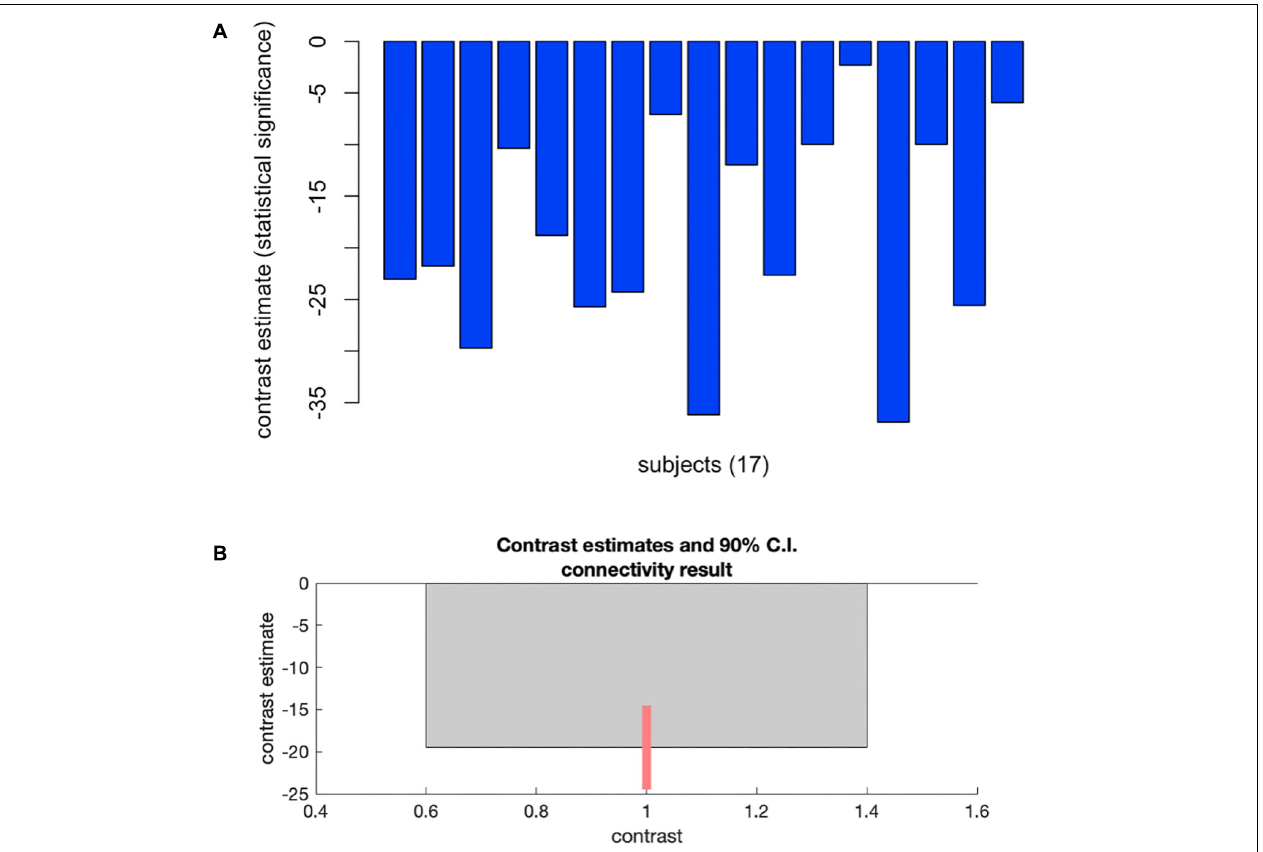
FIGURE 2 | Plots showing changes in whole-brain functional connectivity after a minimum of 60 days of estradiol therapy using multivoxel pattern analysis. (A) Plots individual changes in FC between the cluster within the subcallosal cortex and the rest of the brain. (B) Shows group average changes in FC (–19.51) between time points, with a 90% confidence interval (C.I: –25.4 to –13.52). Cluster size p-FDR <